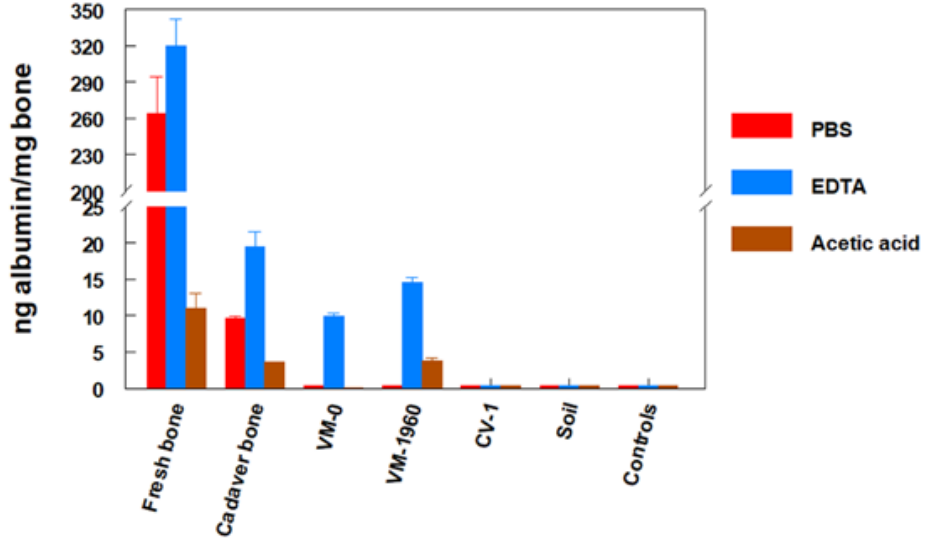
Figure 2. Reactivity of EDTA extracts of fossils from the Venta Micena site with three polyspecific mouse sera against human, baboon, and horse albumin in an enzyme-linked immunosorbent assay. VM-0 (skull fragment) and VM-1960 (humeral diaphysis) were assigned to hominins; EEG is a skull fragment of an equid fossil. All three specimens were dated to 1.3 million years old. The results are expressed as relative immunological similarity, defined as the ratio of each reaction to the homologous (most specific) albumin determination. VM-0 and VM-1960 produced a pattern of reactions similar to modern human albumin, whereas EEG produced a pattern of reactions similar to modern horse albumin. From Borja et al. [42], with permission.